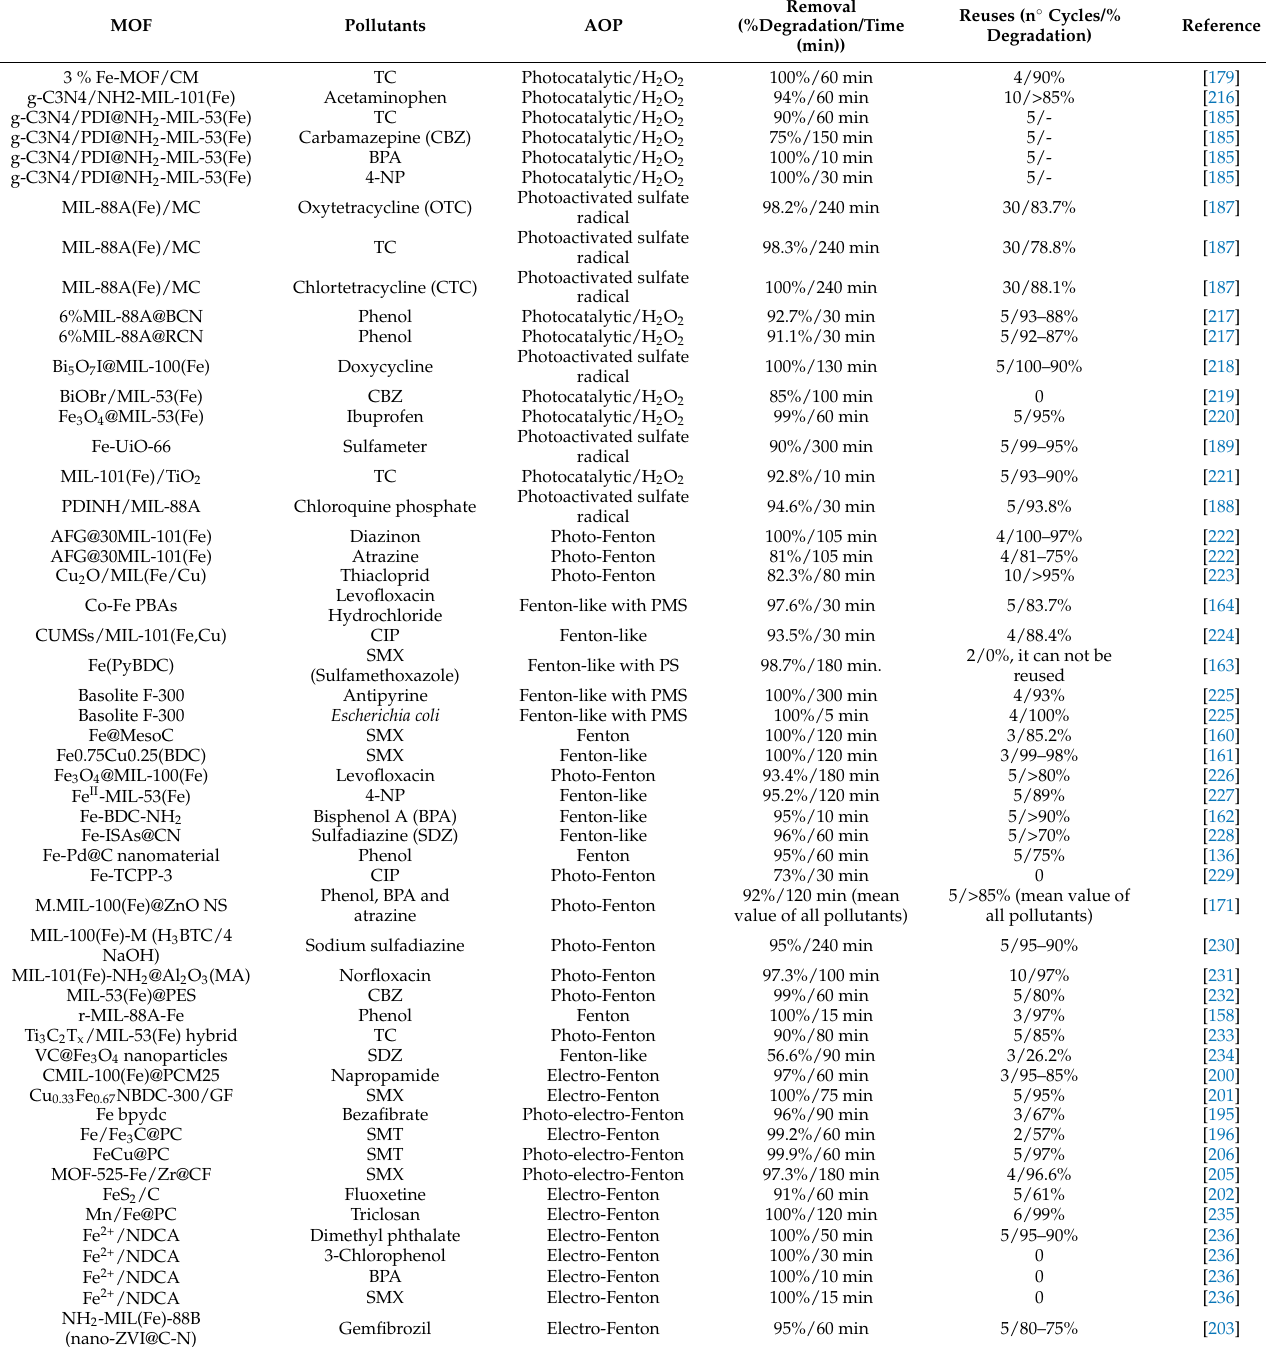
Table 6. Summary of some of the Fe-MOF in catalyst, photocatalyst and electrochemical